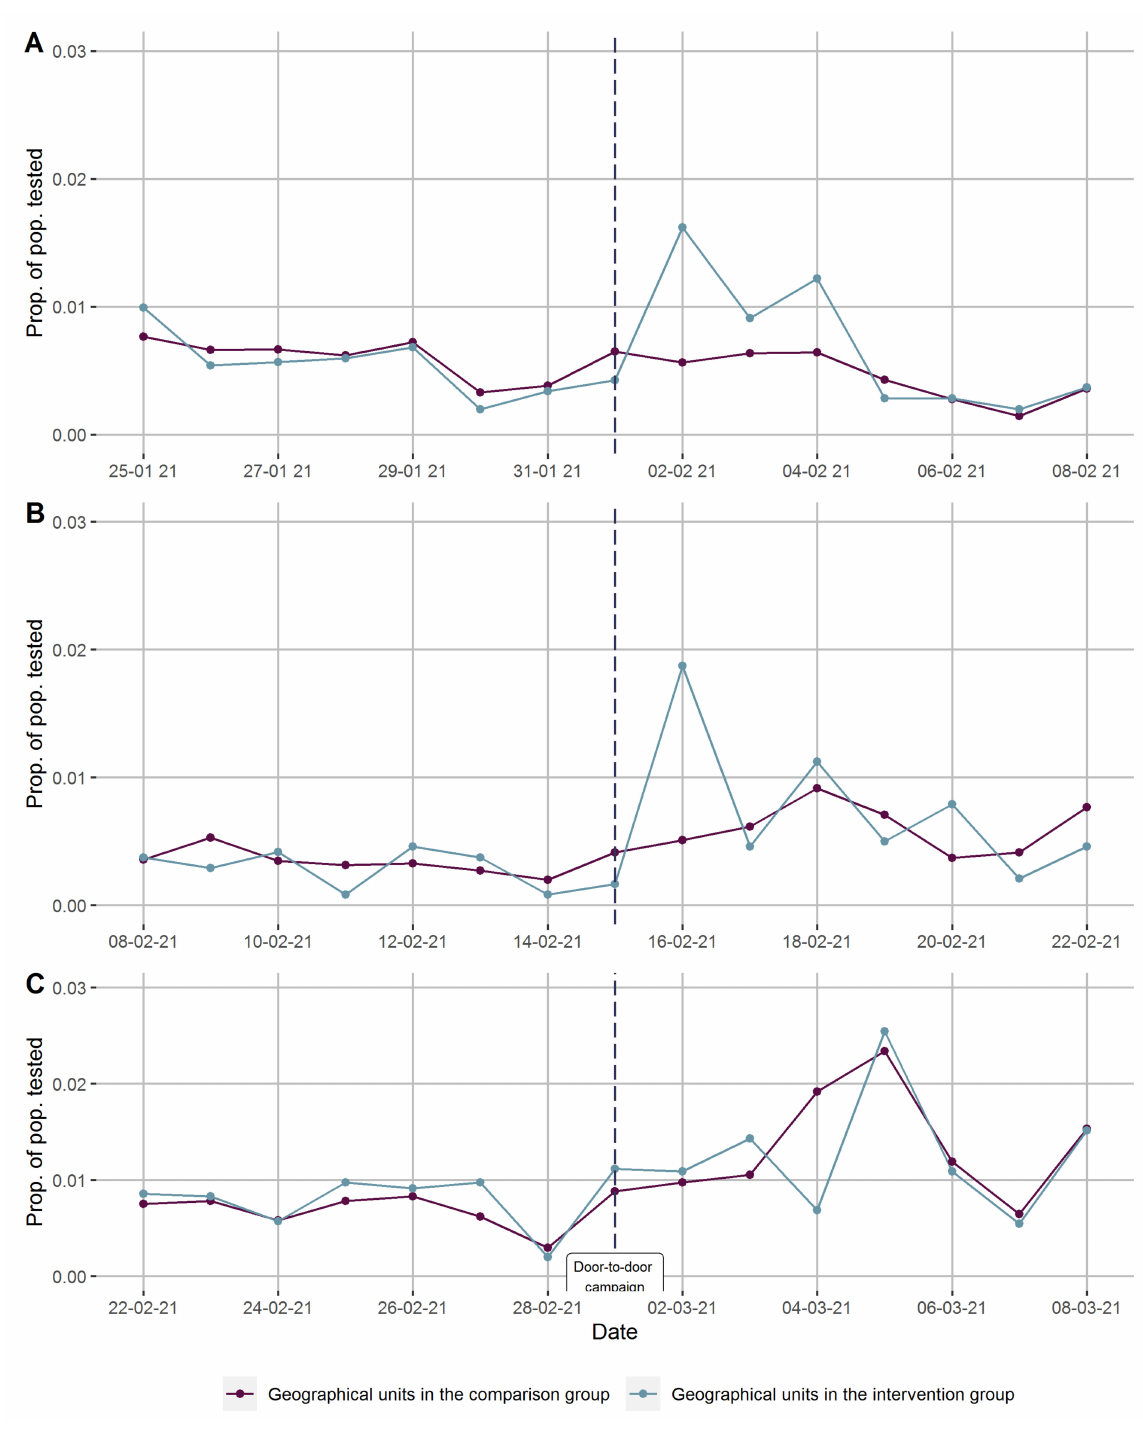
Figure 3. ( A – C ) Proportions of the population tested for COVID-19 before and after three separate door-to-door campaigns promoting COVID-19 testing (day 0) accompanied by mobile testing facilities in geographical units stratified on intervention. A: first round, B: second round, and C: third